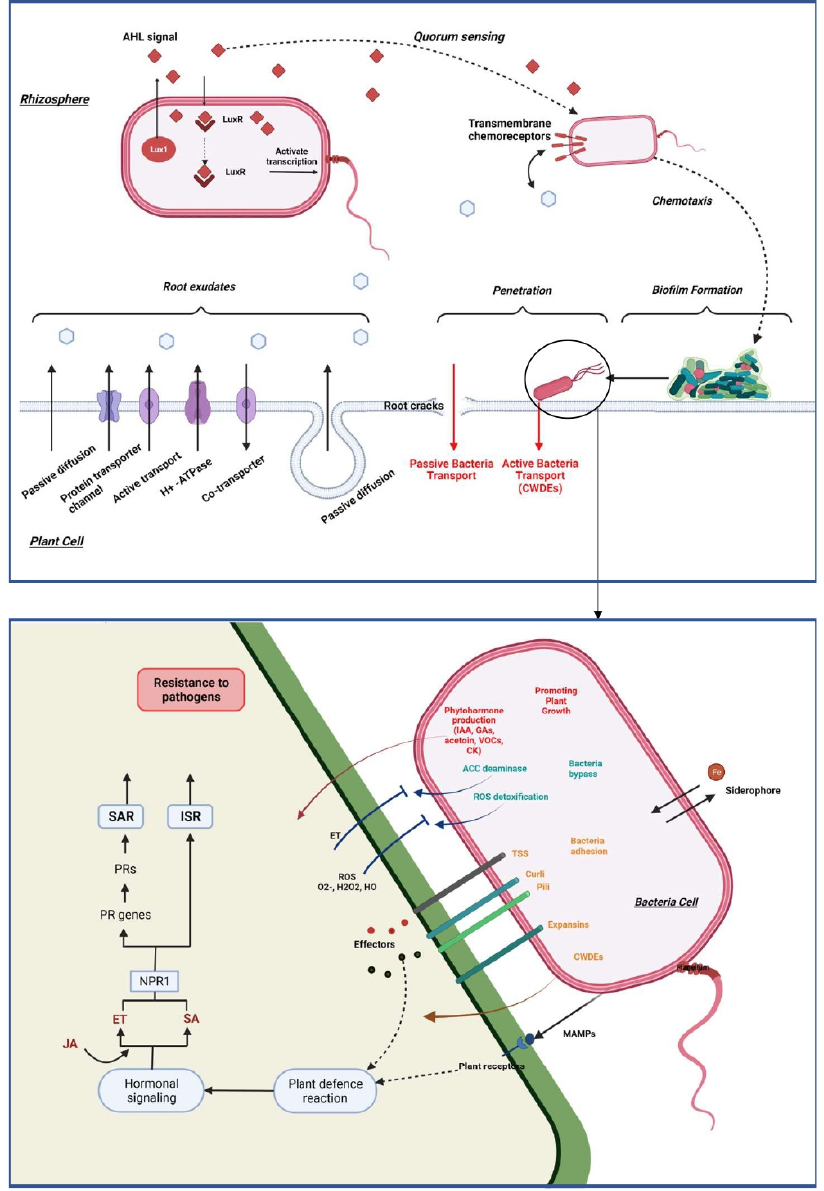
Figure 3. Schematic of plant-bacteria interactions. Abbreviations used in the figure: reactive oxygen species (ROS), oxide anion (O2), hydrogen peroxide (H2O2), type III secretion system (T3SS), type VI secretion system (T6SS), microbe-associated molecular patterns (MAMPs), jasmonic acid (JA), ethylene (ET), salicylic acid (SA), pathogenesis-related proteins (PRs), the nonexpressor of pathogenesis-related gene 1 (NPR1), induced systemic resistance (ISR) and systemic acquired resistance (SAR).